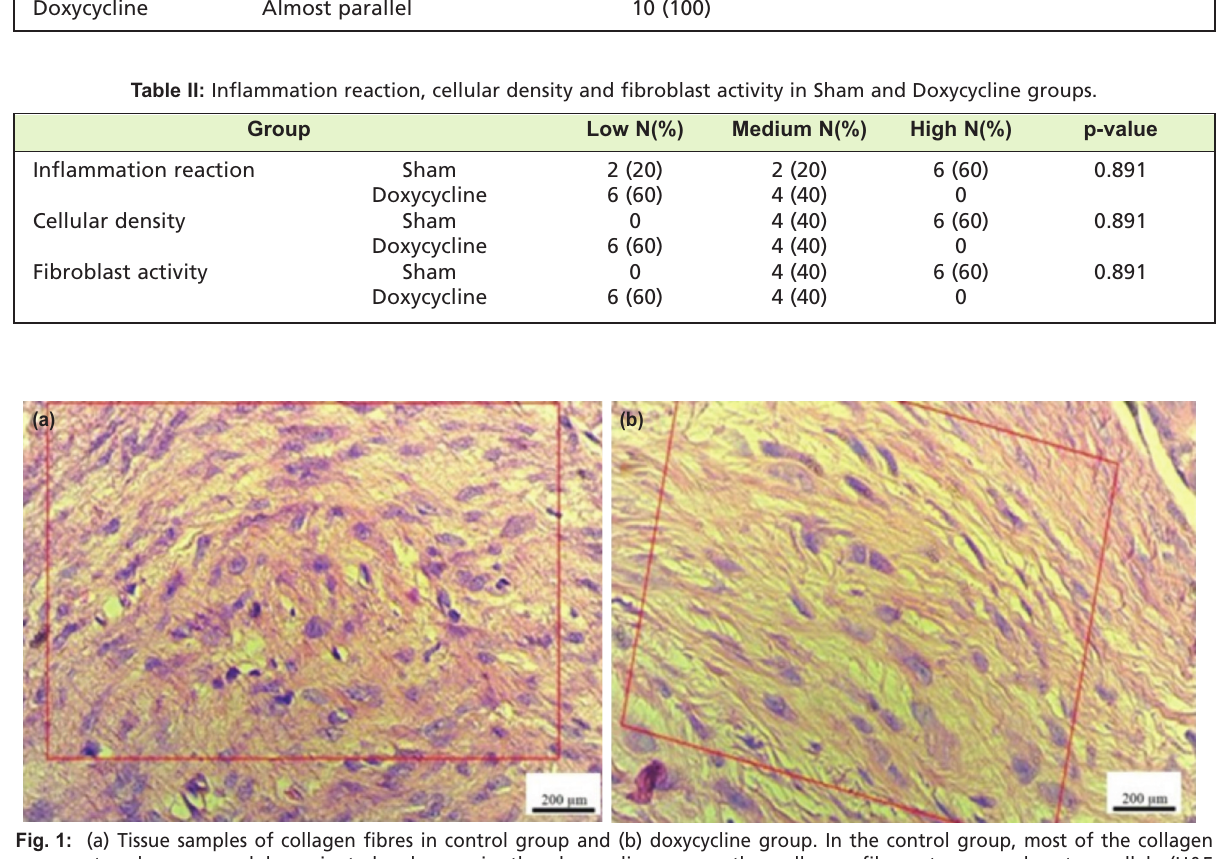
(a) Tissue samples of collagen fibres in control group and (b) doxycycline group. In the control group, most of the collagen Fig. 1: strands were nodular oriented, whereas in the doxycycline group the collagen filaments were almost parallel. (H&E magnification 40×, scale bar 200 µm).